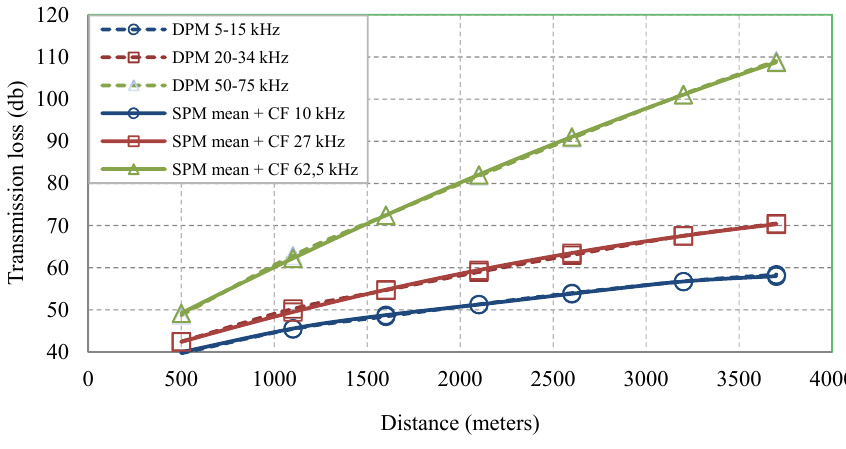
Figure 8. Attenuation vs. distance with different node movement at 5-15 kHz bandwidth